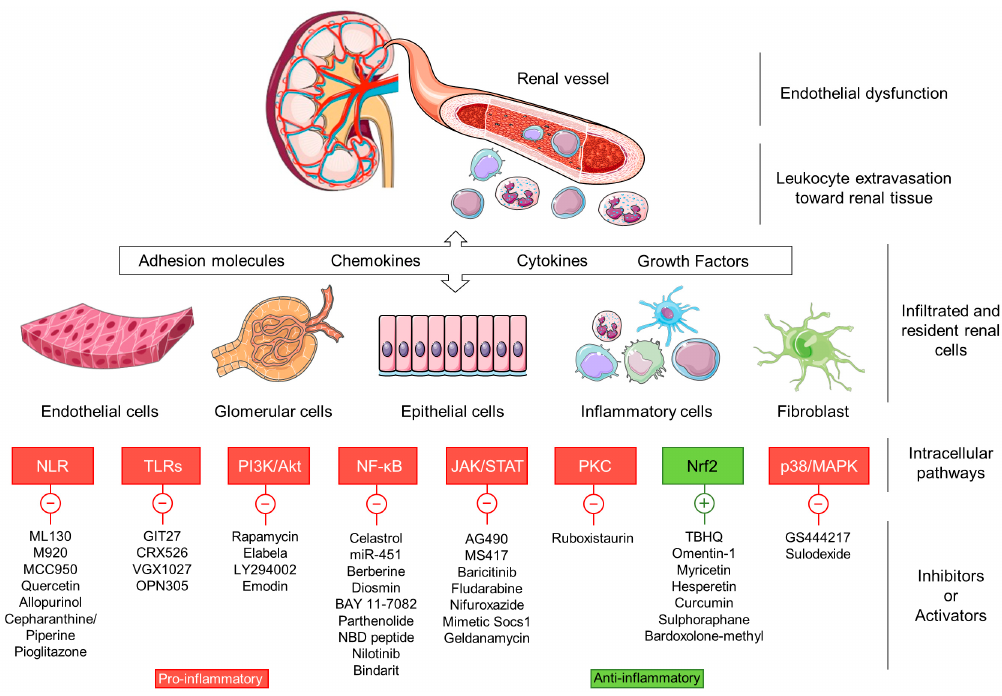
Figure 3. Therapeutic compounds targeting proinflammatory intracellular signaling pathways in DN.